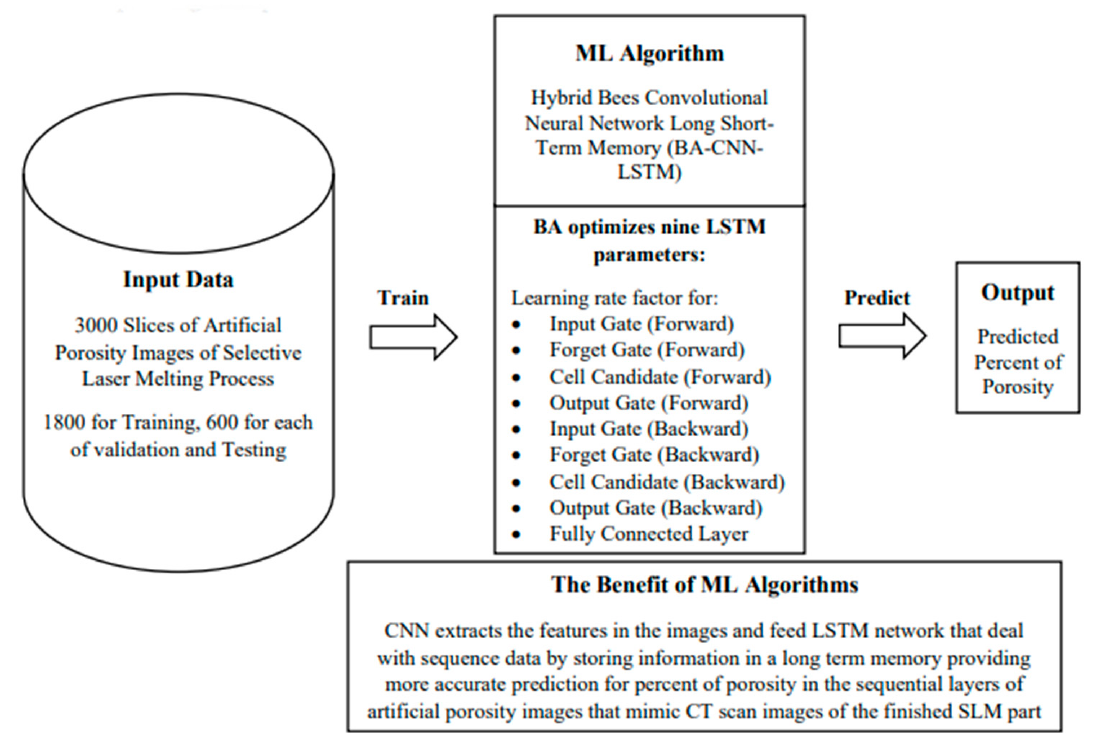
Figure 3. The general framework for the proposed BA-CNN-LSTM algorithm.